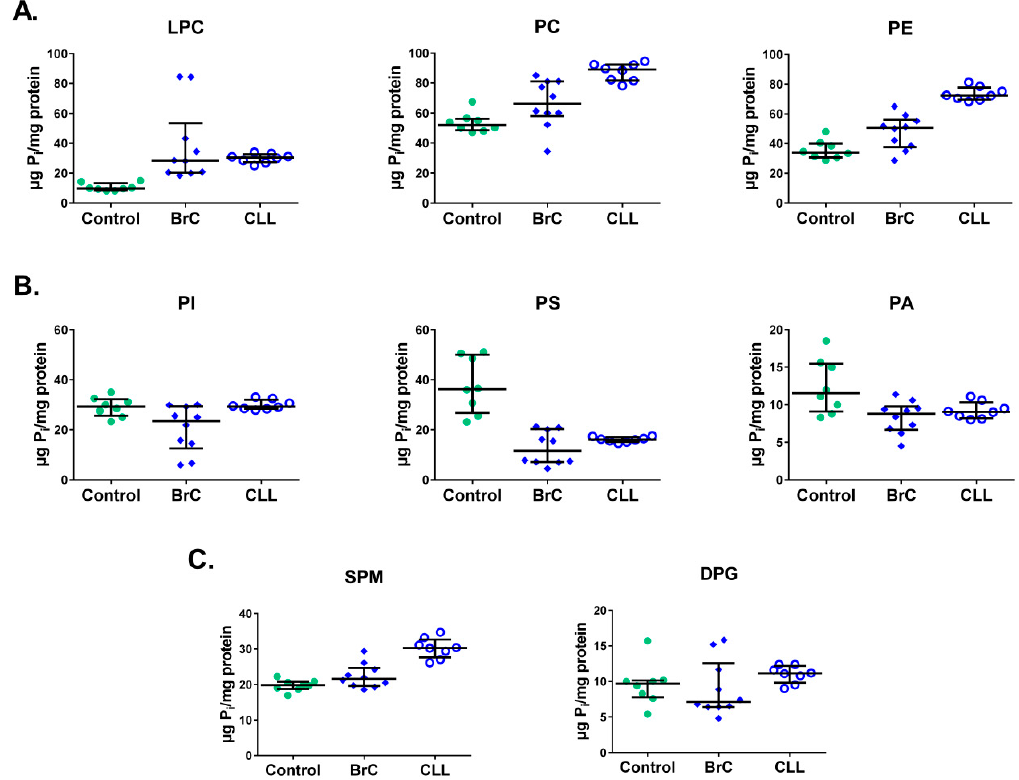
Figure 3. Different PL fraction levels ( µ g Pi/mg protein) in membranes of MNCs of healthy individuals (control) and from patients with BrC and CLL. ( A ) LPL, PC, and PE; ( B ) PI, PS, and PA; ( C ) SPM and DPG. Most of the differences in PL fractions between individual cancer conditions and controls mostly agree with findings of the PL pool (Figures 1 and 2). Statistical differences between BrC ( n = 10) or CLL ( n = 8) and controls ( n = 8) were assessed using Mann–Whitney test with 95% CI. In contrast, in CLL samples there was no difference in the levels of PI (Figure 3B), and SPM level